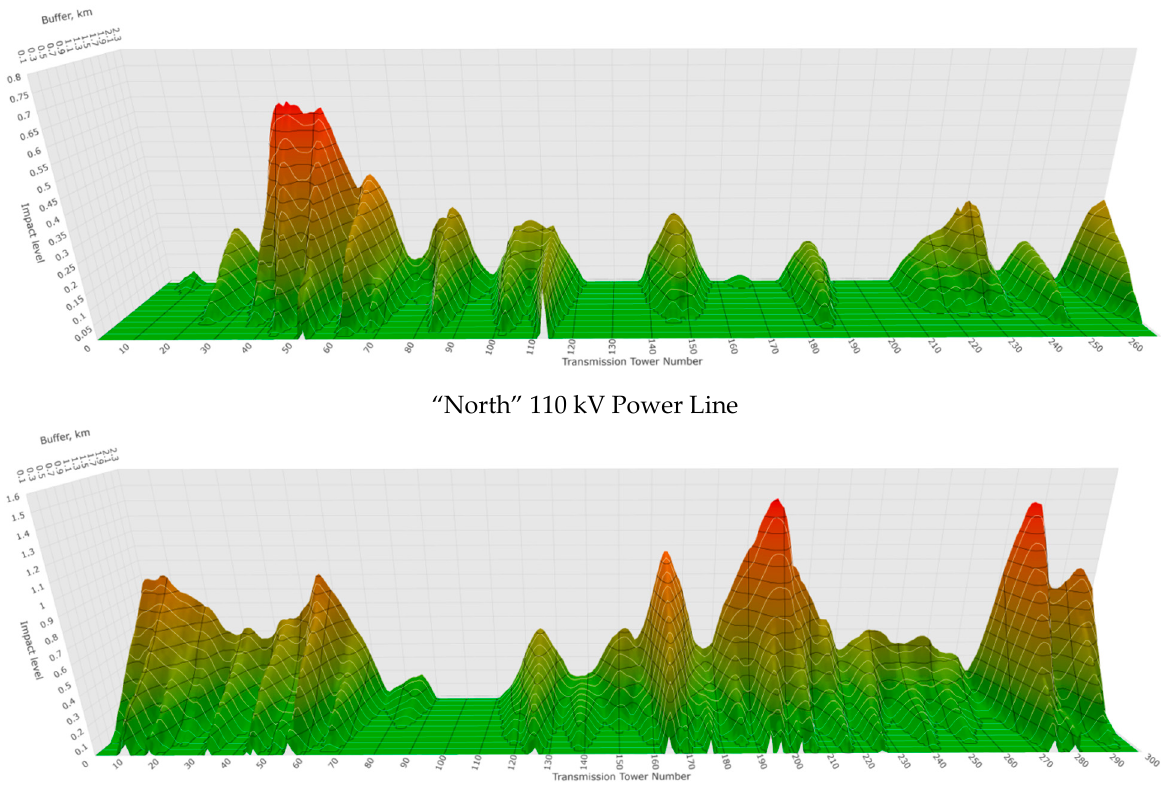
Figure 5. The average annual lightning impact intensity on the “North” and “South” overhead transmission lines. Note the different magnitude of the impact level.